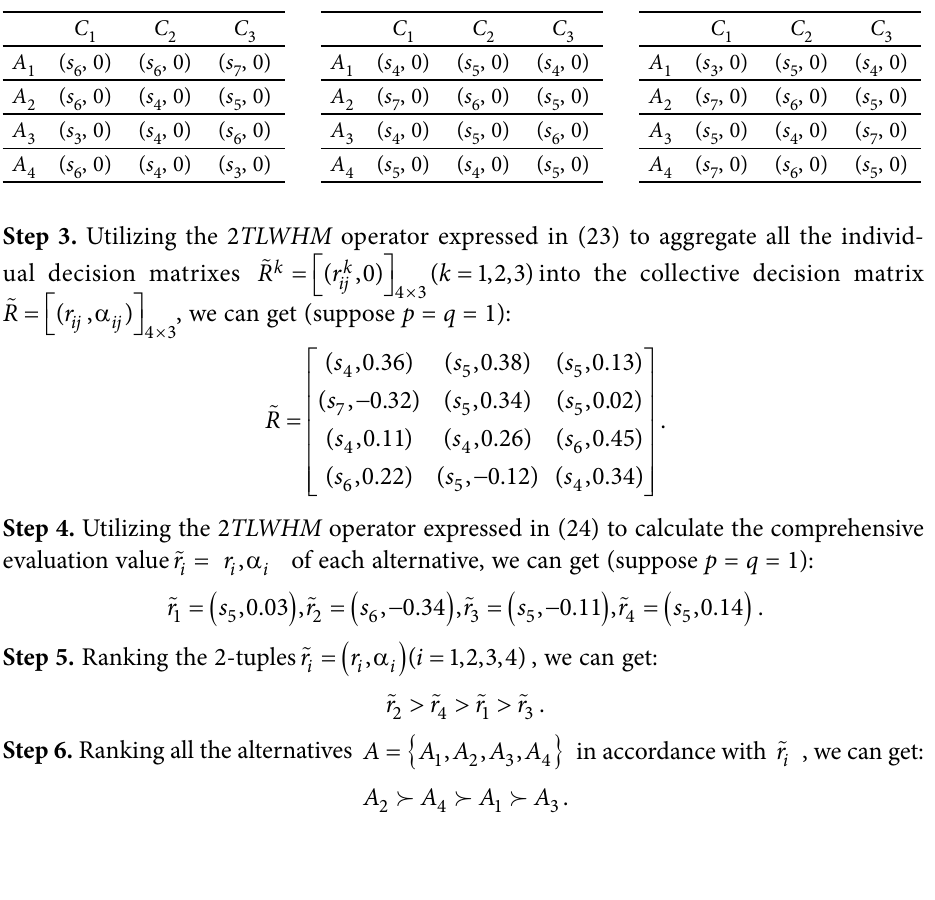
Table 5. 2-tuple linguistic decision matrix 2 R 